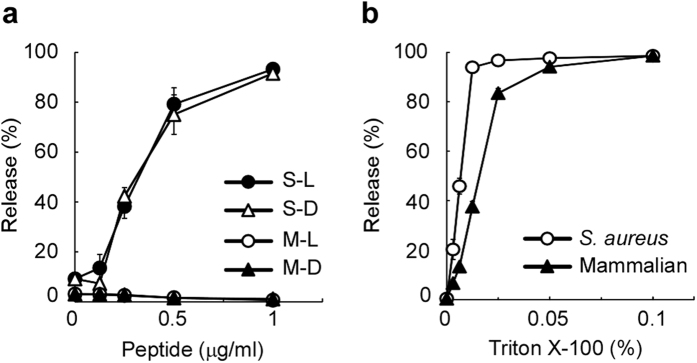
D-form and L-form KLKLLLLLKLK-NH2 disrupt S. aureus-mimetic liposomes.(a) S. aureus-type and mammalian-type liposomes with calcein were exposed to D-form and L-form KLKLLLLLKLK-NH2: S-L, S. aureus-mimetic liposomes treated with L-form peptide; S-D, S. aureus-mimetic liposomes treated with D-form peptide; M-L, mammalian-mimetic liposomes treated with L-form peptide; and M-D, mammalian-mimetic liposomes treated with D-form peptide. (b) S. aureus-type (S. aureus) and mammalian-type (Mammalian) liposomes containing calcein were exposed to Triton X-100. The amount of calcein that leaked from the liposomes was measured using a spectrofluorophotometer and normalized to determine the % release relative to 0.1% Triton X-100. The error bars represent the mean ± standard deviations from triplicate assays.